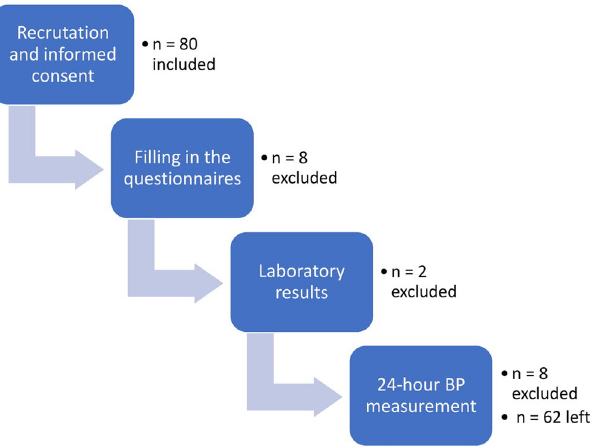
Figure 1. Flow diagram of the study and order of the procedures. BP blood pressure. All figures made by authors of the manuscript. GraphPad Prism 9 (https:// www. graph pad. com/) was used to create forest